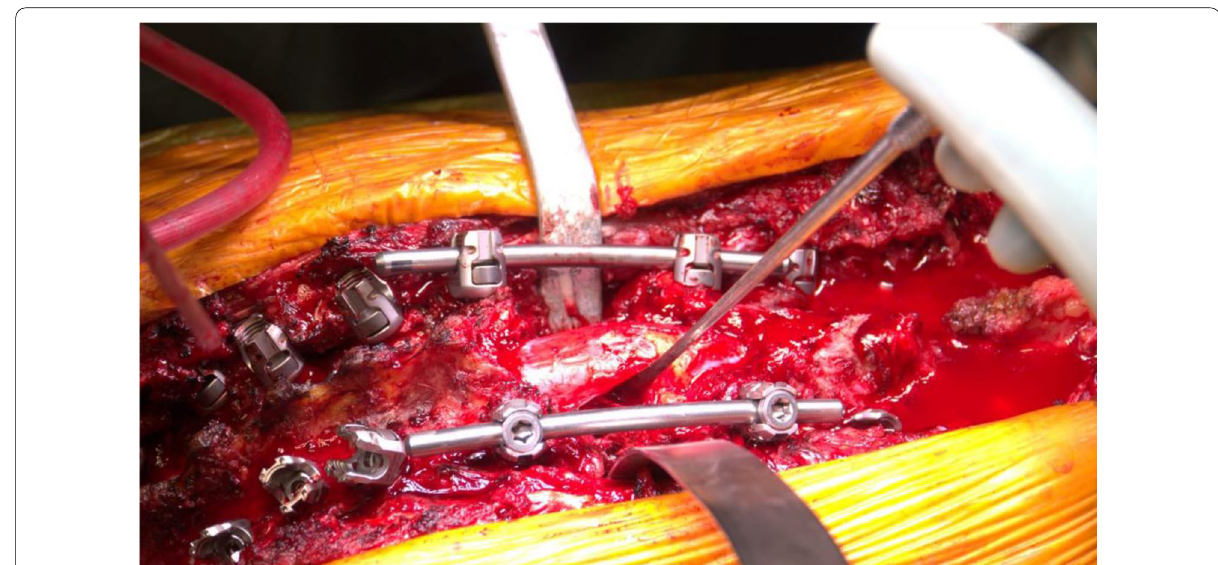
Fig. 5 Careful assessment of the complete posterior wall resection in order to avoid dural sac entrapment during the subsequent osteotomy closure